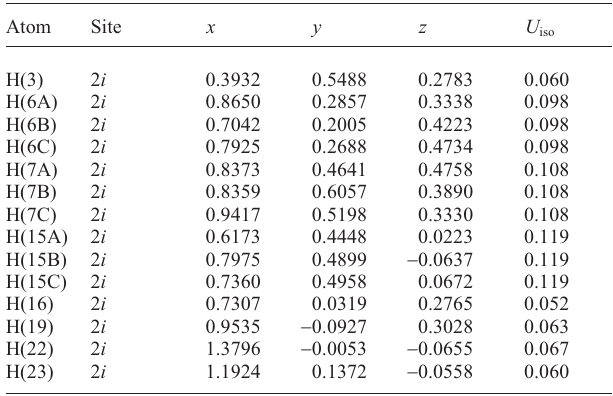
Table 2. Atomic coordinates and displacement parameters (in Å 2 ) .